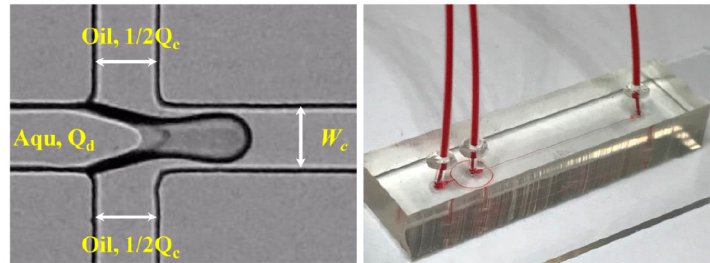
Figure 2. Channel configuration and assembled microchip. All the openings of the cross-slot channel are 50 µ m. Q c and Q d represent the flow rates of the continuous phase and dispersed phase, respectively. Red ink was infused to visualize the channel structure in the assembled chip.